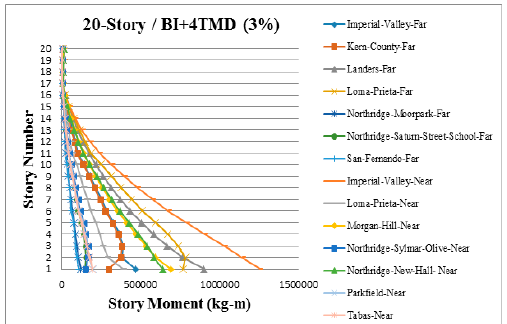
Figure A27. Peak story moments for 20-story base-isolated building with 4 TMDs.